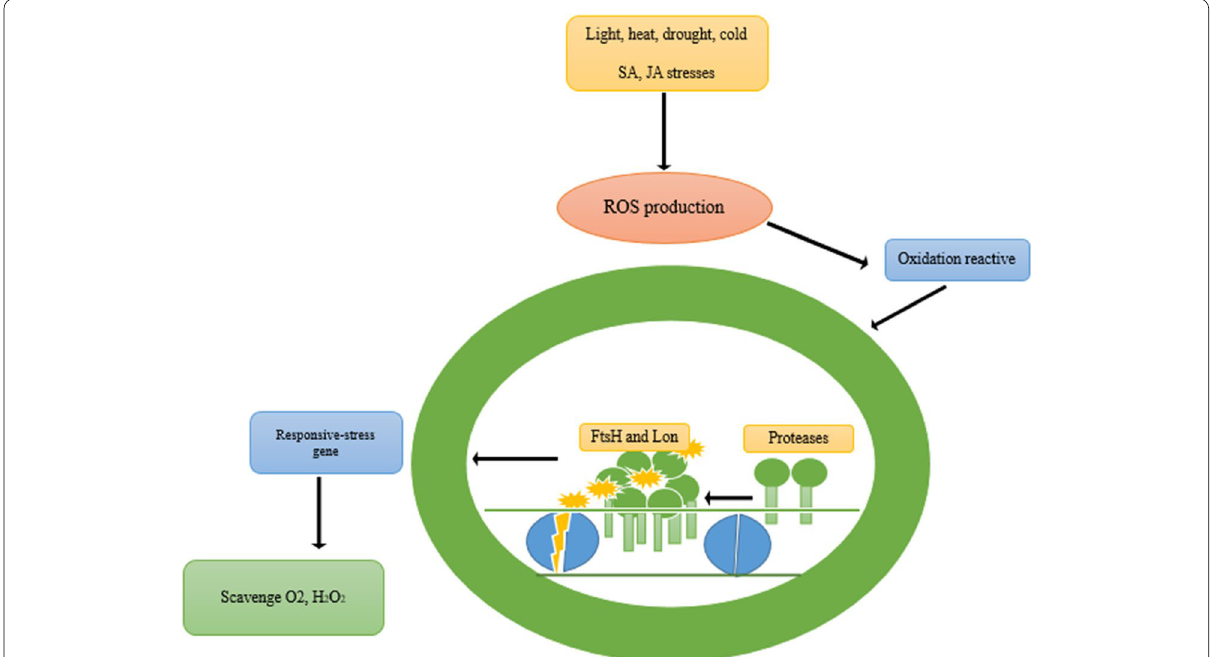
Fig. 1 Stress-induced damage to PSII and removal of the damaged D1 by proteases. These stresses induce ROS production leading to oxidation reactive damages. Plants have evolved adaptive systems like responsive genes, protecting plants against oxidative stress damages. Also, FtsH and Lon repair D1 can assist in quality control of damaged